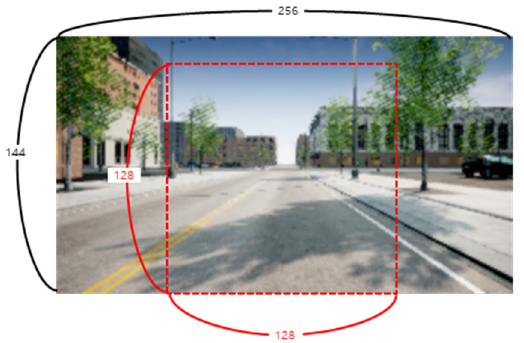
Figure 4. The training environment using AirSim (city road and mountain road).